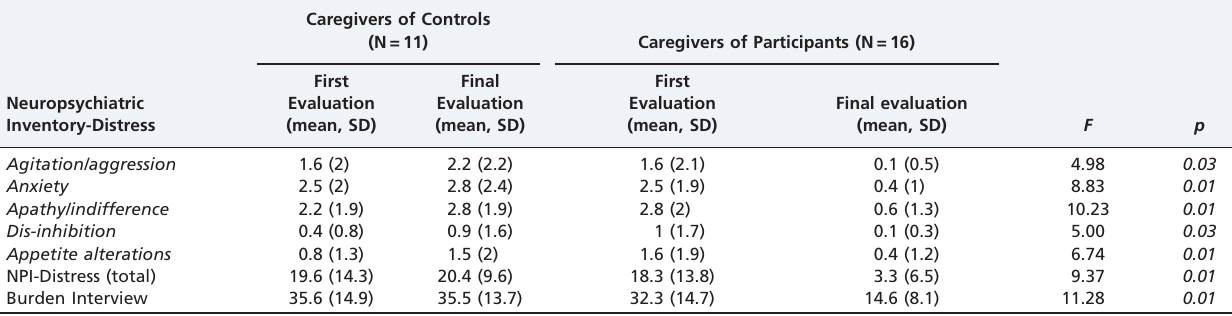
Table 3 - Caregivers’ burden and stress (significant values: mean and SD) related to Neuropsychiatric Inventory domains and Burden Interview among patients with Alzheimer’s disease at baseline and at the time of the final evaluation, after six months of exercise.